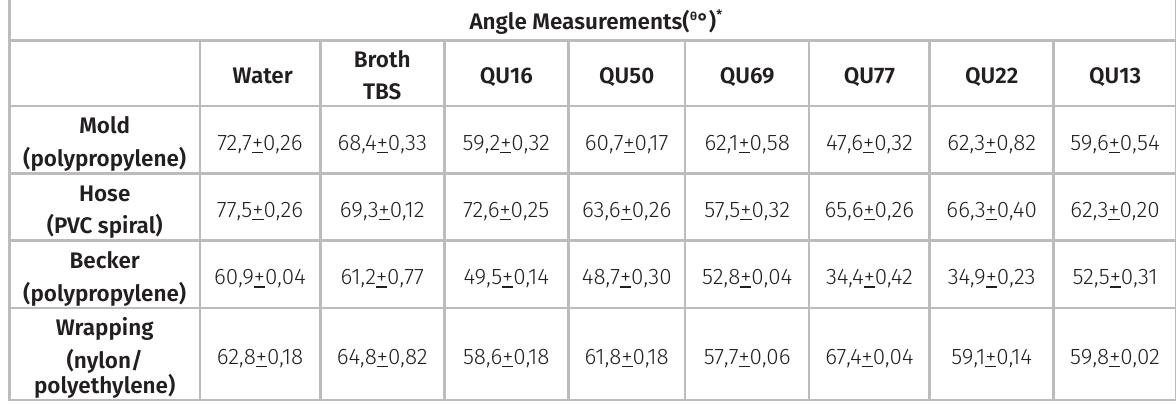
Table II. Sessile drops angle measurements in degrees on the coupons mold, hose and packaging. Angle Measurements(ᶿ°) *